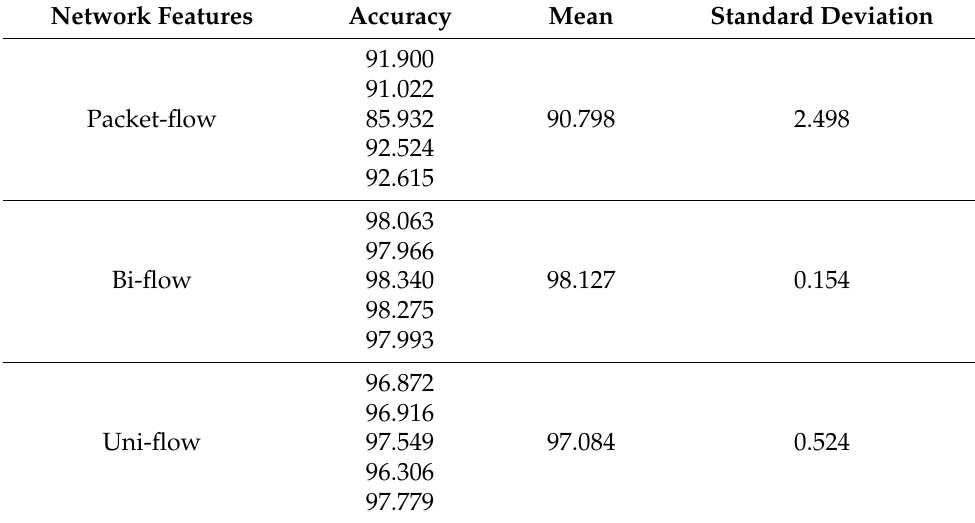
Table 10. Multi-class attacks classification results with five-fold cross validation in terms of